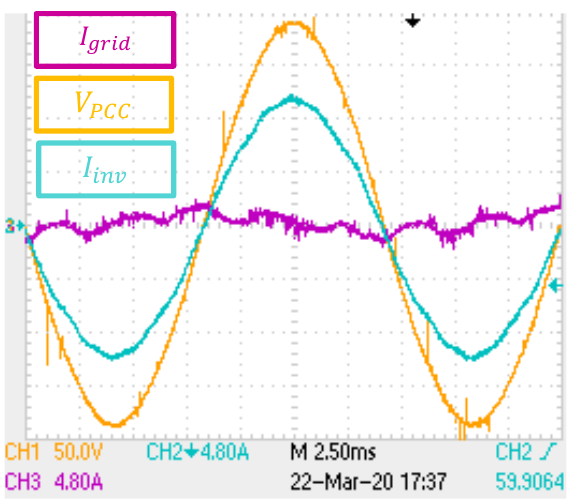
Figure 18. Grid Current, PCC voltage, and Inverter current without the implementation of any active AIP strategy.